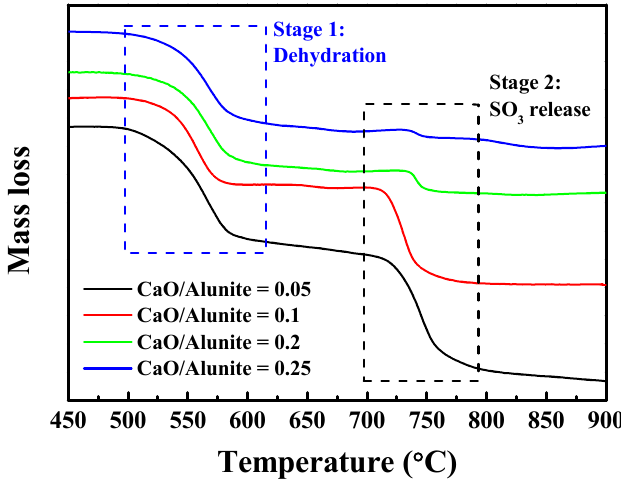
Figure 8. Thermo-gravimetric (TG) curves of the alunite samples with different CaO/alunite ratios during thermal decomposition.